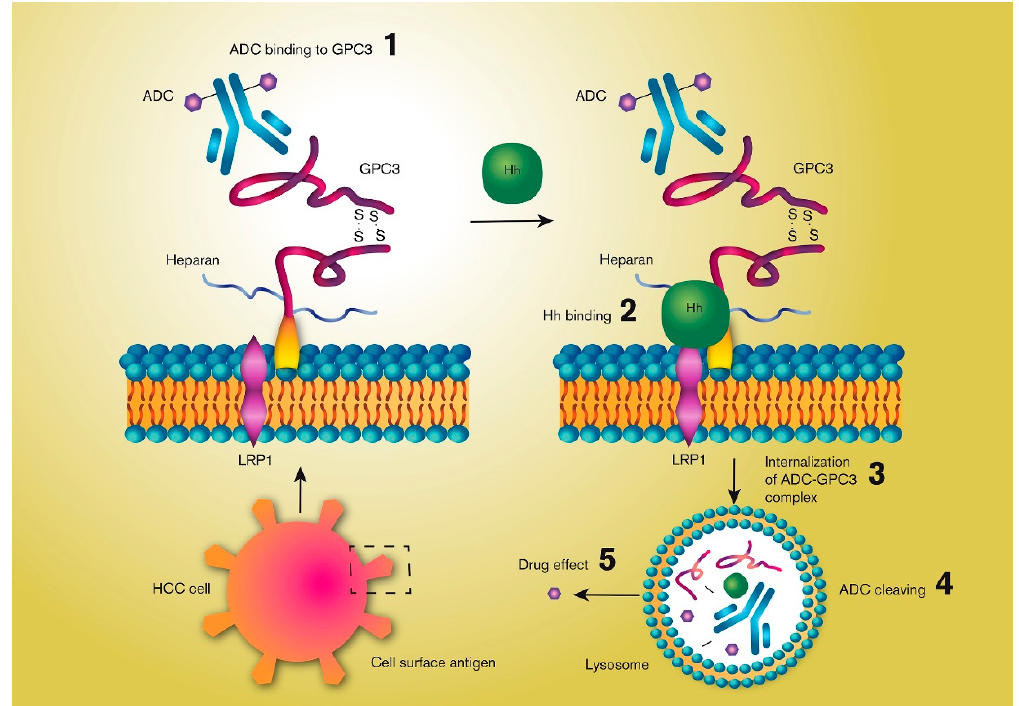
Figure 3. Simplified illustration of the mechanisms by which an antibody-drug conjugate (ADC) may be internalized by a hepatocellular cancer (HCC) cell by targeting the cell surface membrane-bound Glypican-3 (GPC3), a heparan sulfate proteoglycan protein. GPC3 internalization is triggered by its binding to the hedgehog (Hh) polypeptide ligand by a mechanism involving low-density-lipoprotein receptor-related protein-1 (LRP1). An ADC bound to GPC3 can be degraded together with GPC3 following its internalization, which triggers release of the active drug.